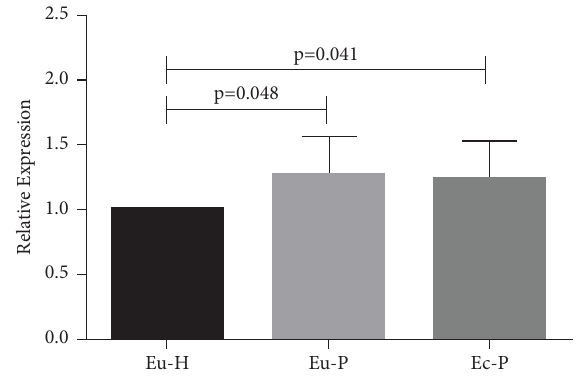
Figure 5: Te relative messenger ribonucleic acid (mRNA) ex- pression of human leukocyte antigen-C (HLA-C) ∗ 07 in patients and healthy women. Te relative mRNA expression of HLA-C ∗ 07 was detected using a quantitative reverse transcription polymerase chain reaction with HLA-C ∗ 07-specifc primers. Eu-H is the eutopic endometrium of healthy women; Eu-P is the eutopic en- dometrium of patients with endometriosis; and Ec-P is the ectopic endometrium of patients with